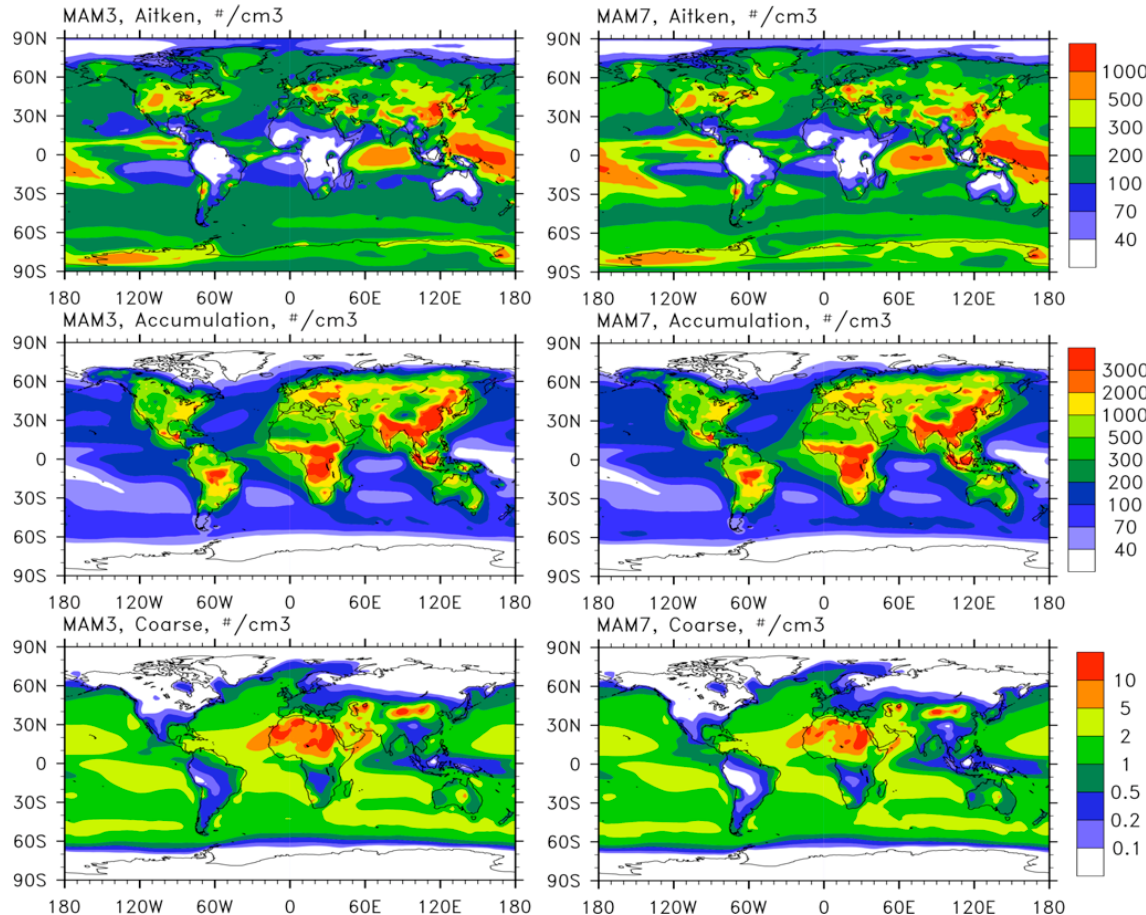
Fig. 5. Annual mean number concentration of aerosol in Aitken, accumulation and coarse mode in the surface layer from MAM3 (left) and MAM7 (right) at standard temperature and pressure (1013.25hPa,